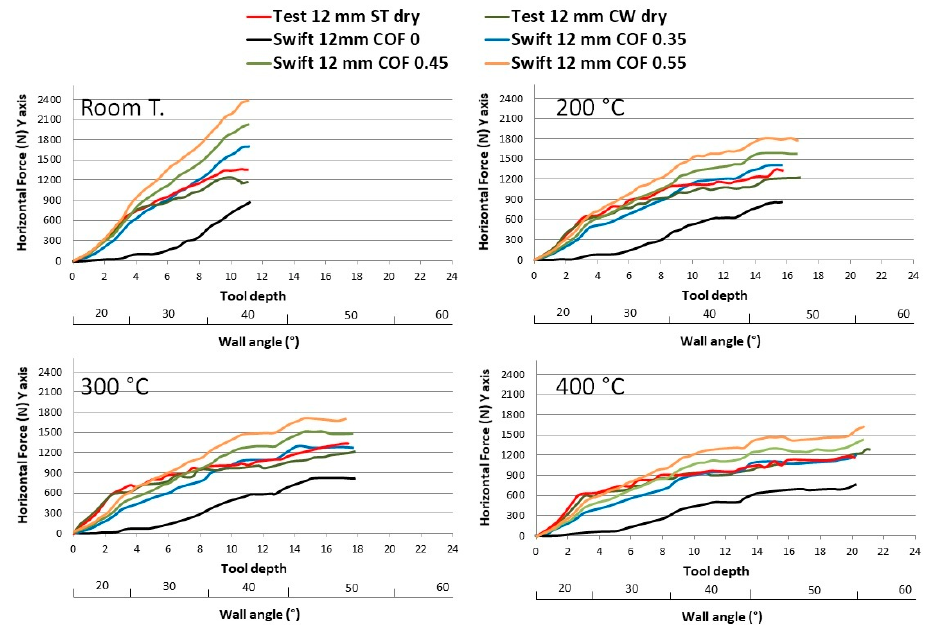
Figure 11. Summary of the radial forces recorded at different temperatures.